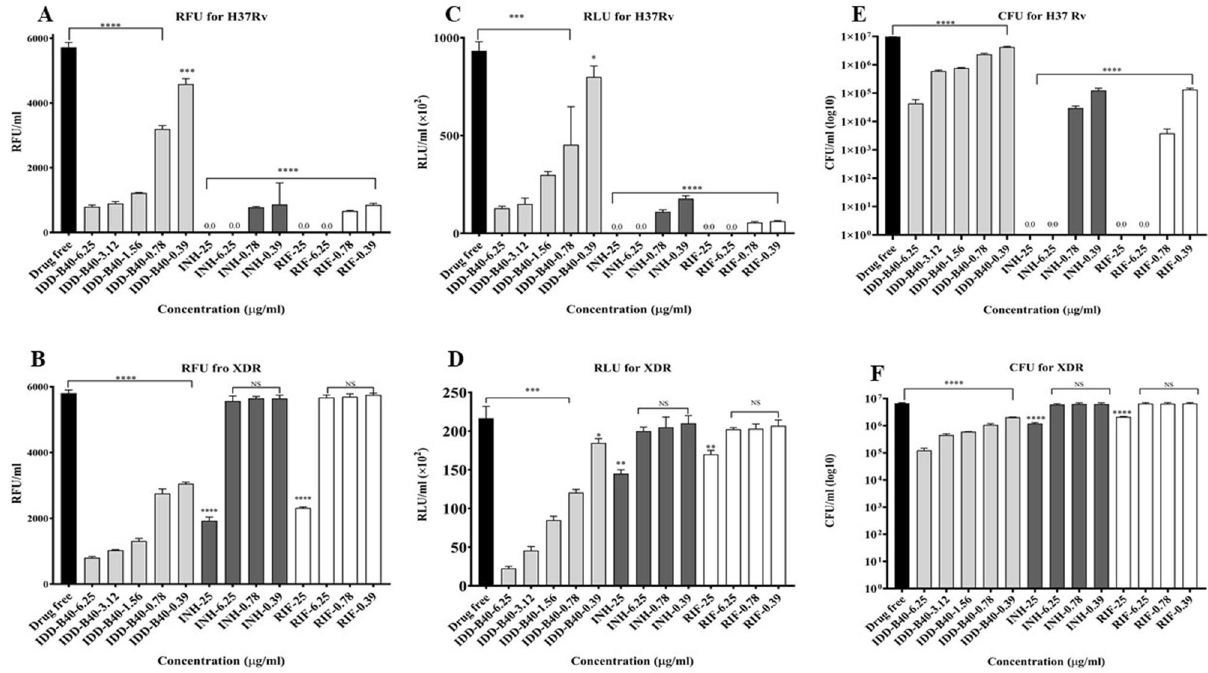
Figure 2. Antimicrobial activities of IDD-B40 and control drugs, including isoniazid (INH) and rifampicin (RIF), against M. tuberculosis H37Rv ( A , C , E ) and extensively drug-resistant (XDR)- M. tuberculosis ( B , D , F ). Mycobacterial susceptibility was assessed by resazurin assay ( A , B ) as RFU/ml (relative fluorescence unit per ml), by microbial cell viability assay ( C , D ) as RLU/ml (relative luminescence unit per ml), and by CFU enumeration assay ( E , F ) as CFU/ml. These experiments were carried out in triplicate. Data are given as mean values and standard deviations. *Statistical significance were determined in Graph Pad Prism 8.2.0 between drug treated versus drug-free control using an unpaired Student’s t test (* p < 0.05, ** p < 0.01, *** p < 0.001, **** p < 0.0001).